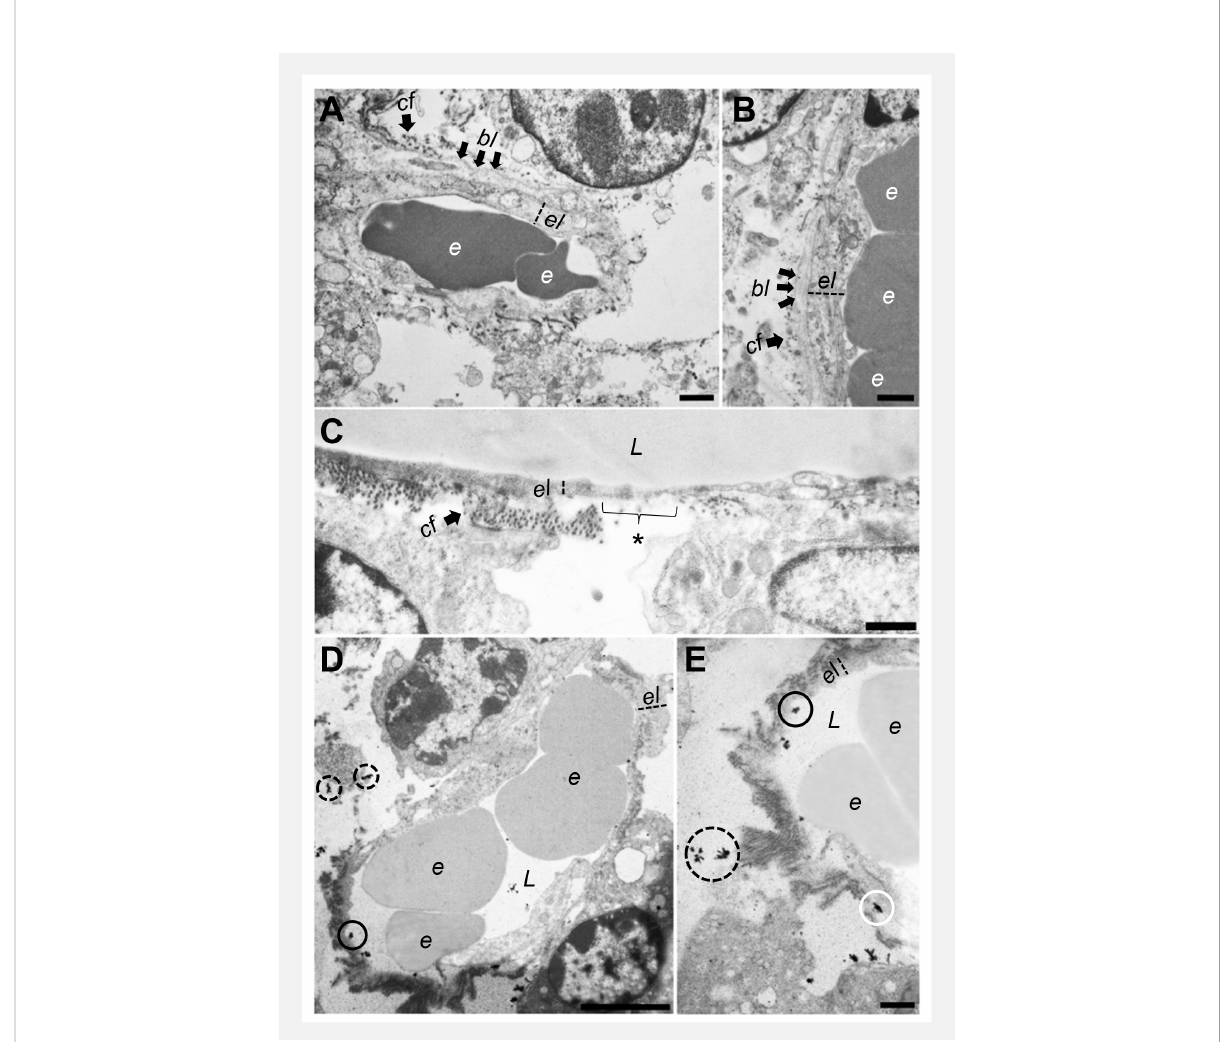
FIGURE 8 Transmission electron microscopy of endothelial cells. 67NR tumor vessels (A, B) show intact and continuous endothelial layers with an uninterrupted basal lamina and collagen fi brils on the outside. 4T1 tumors (C) show overall thinner endothelial layers with interruptions of the basal lamina and the collagenous layer (asterisk). Representative images of 4T1 tumors after gadofosveset injection (D, E) show the presence of electron dense contrast agent in the lumen of the vessels (black circles), between endothelial cells and basal lamina (white circle), and additionally, extravasated outside of the vessels (dashed circles). Scale bars represent 1 m m. e = erythrocyte, el = endothelial layer, bl = basal lamina, cf = collagen fi brils, L = lumen